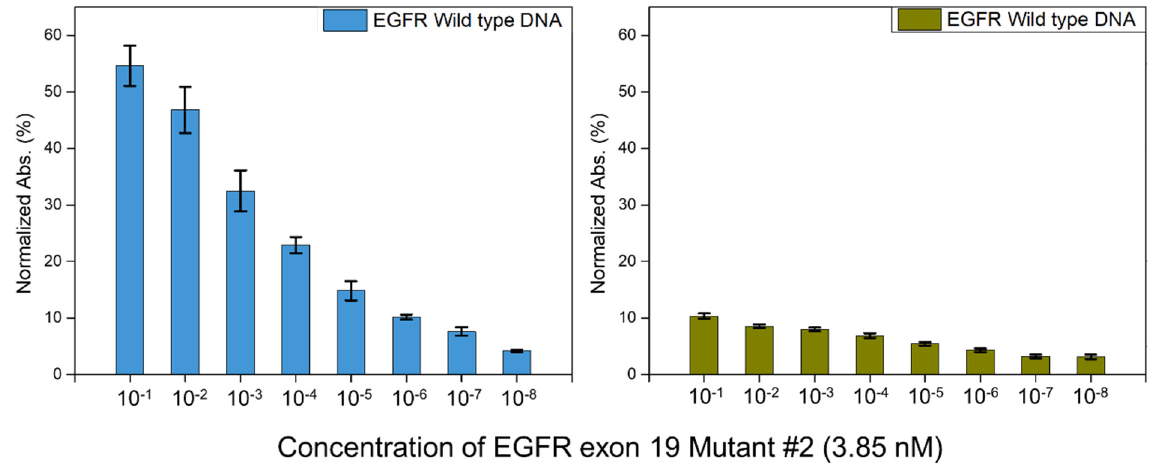
Figure 4. Detection of EGFR exon 19 deletion mutant #2. Detection of EGFR exon 19 wild type DNA (green) and EGFR exon 19 deletion mutant #2 DNA (blue). The exact value of detection of EGFR exon 19 wild type DNA (green) is 10.3% ± 0.4%, 8.5% ± 0.3%, 7.9% ± 0.3%, 6.8% ± 0.4%, 5.4% ± 0.3%, 4.2% ± 0.3%, 3.1% ± 0.3%, and 3.1% ± 0.3%, and the exact value of detection of EGFR exon 19 deletion mutant #2 DNA (blue) is 54.5% ± 3.5%, 46.8% ± 4.0%, 32.4% ± 3.6%, 22.9% ± 1.4%, 14.8% ± 1.7%, 10.1% ± 0.4%, 7.6% ± 0.7 %, and 4.1% ± 0.2% in order of the concentrations of template and target DNA. Each concentration has been tested at least three times.